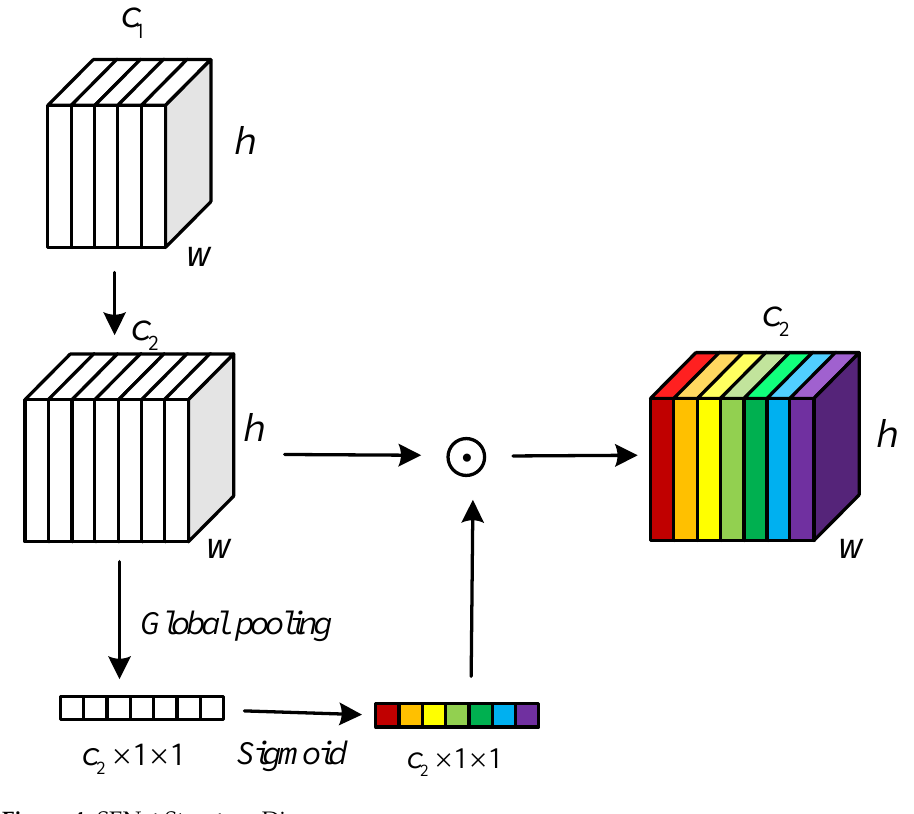
Figure 4. SENet Structure Diagram .